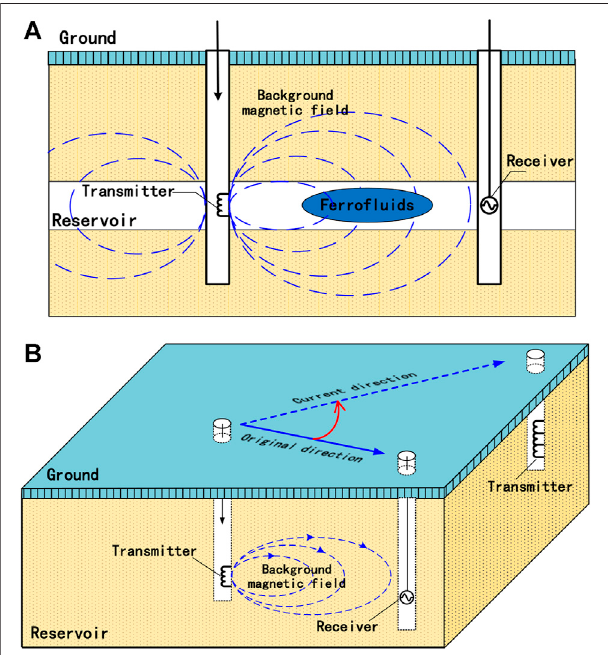
FIGURE 1 | Schematic diagram of ferro fl uid fl ooding technology: (A) Displacement front monitoring and tracking; (B) Displacement direction guiding and